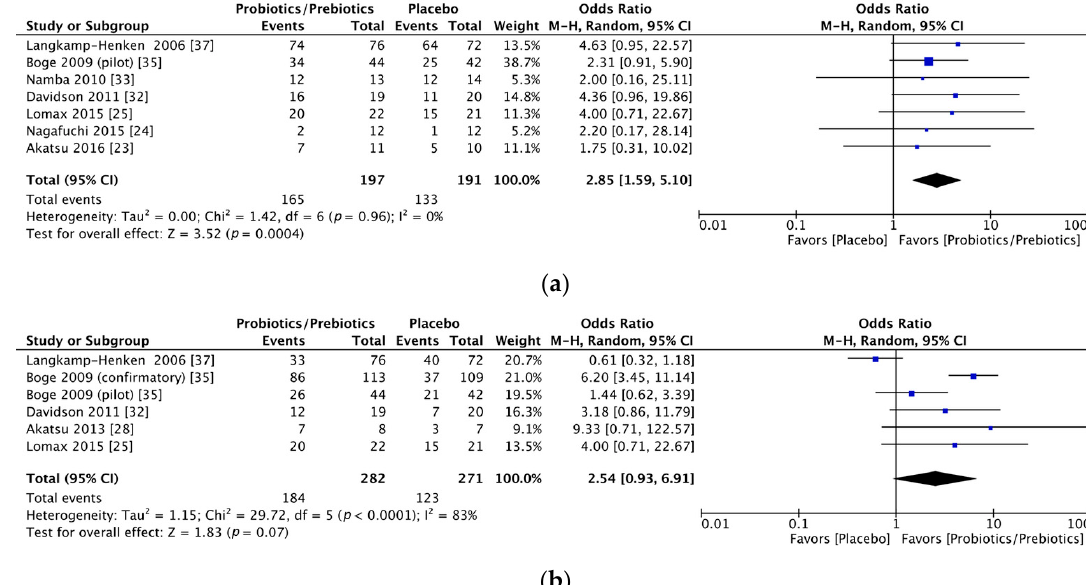
Figure 3. Forest plots of seroprotection and seroconversion rate of H3N2 strain. ( a ) Forest plot of seroprotection rate of H3N2 strain; ( b ) Forest plot of seroconversion rate of H3N2 strain. The bold data represents total participants of all included studies and the Odds ratio (OR) between the probiotics/prebiotics group and the placebo group. The diamond stands for the pooled OR. Weights are from random-effects model. CI: confidence interval.